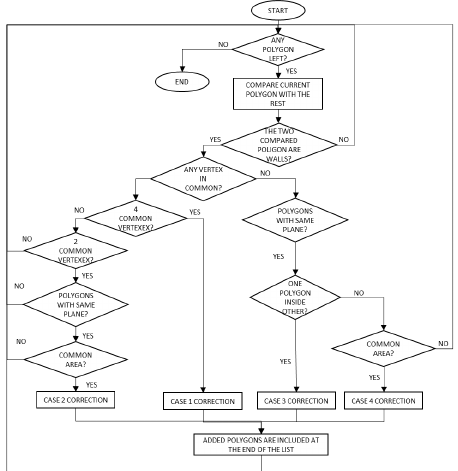
Figure 1. Merge Algorithm Diagram